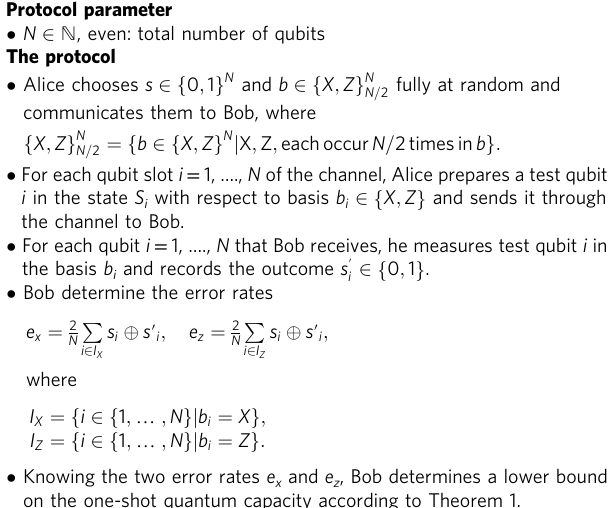
Table 1 Protocol 1: The estimation protocol One-shot quantum capacity